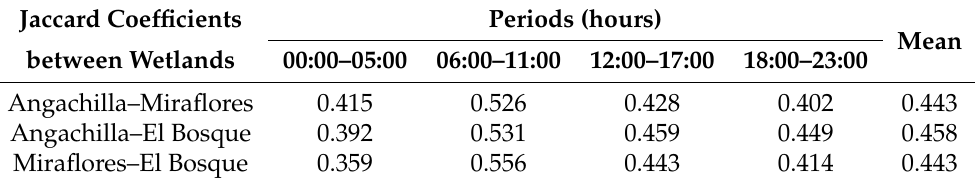
Table 1. Temporal variations of average Jaccard coefficient J in four periods of six hours.